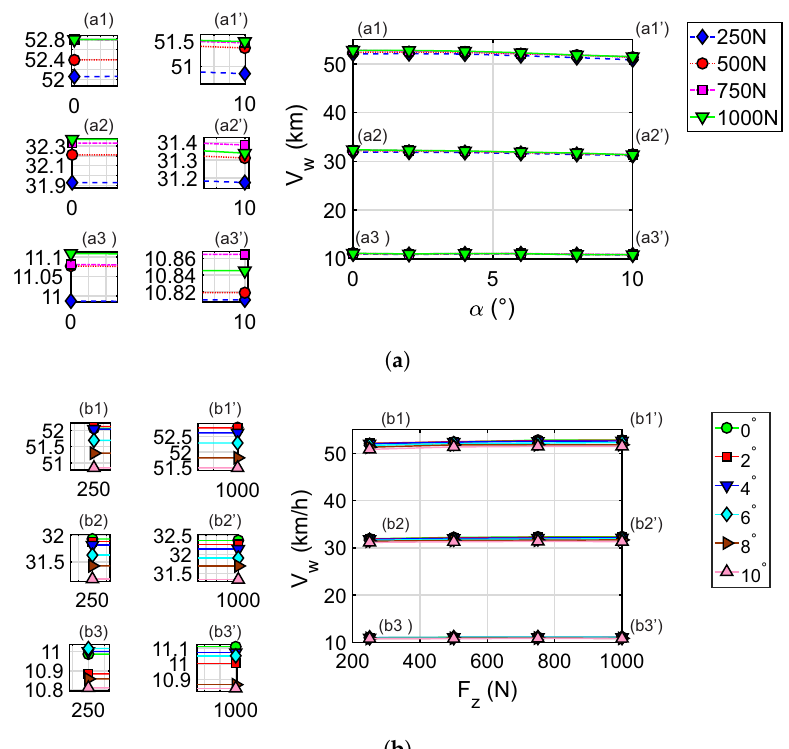
Figure 13. Results of the wheel speed in the contact footprint obtained by applying the proposed methodology to the experimental data.( a ) Data differentiated by vertical load; ( b ) Data differentiated by slip angle.